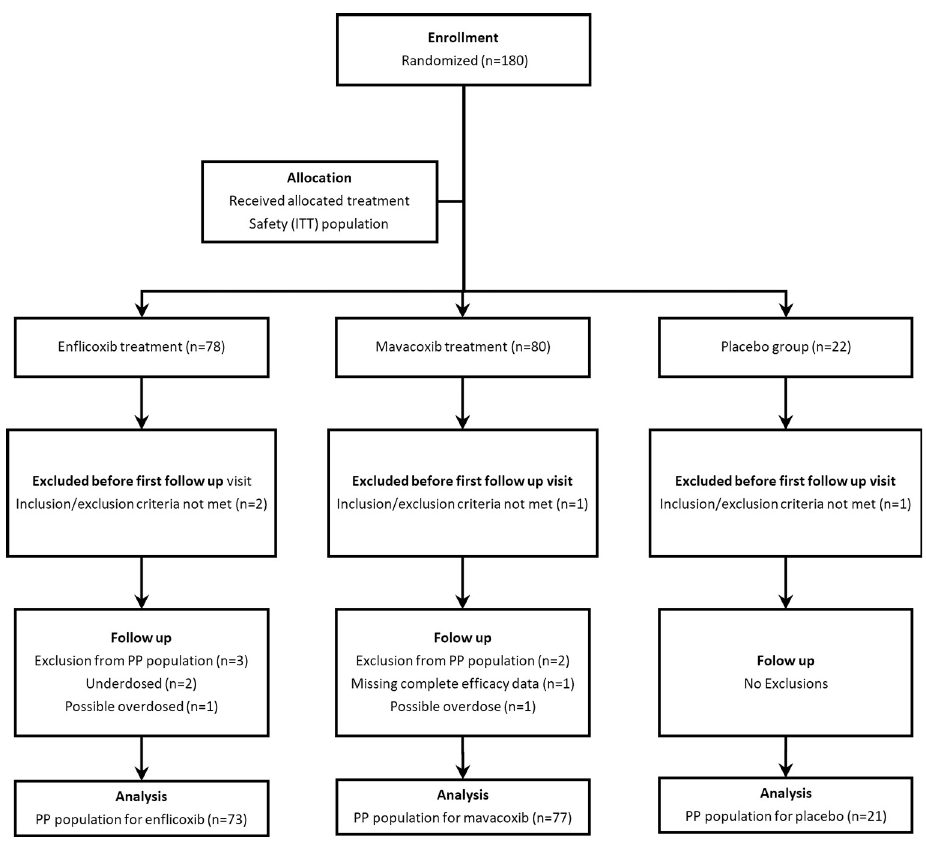
Fig 1. Flowchart showing number of patients recruited, allocated to each treatment, and analysed. (ITT: Intention To Treat; PP: Per Protocol).